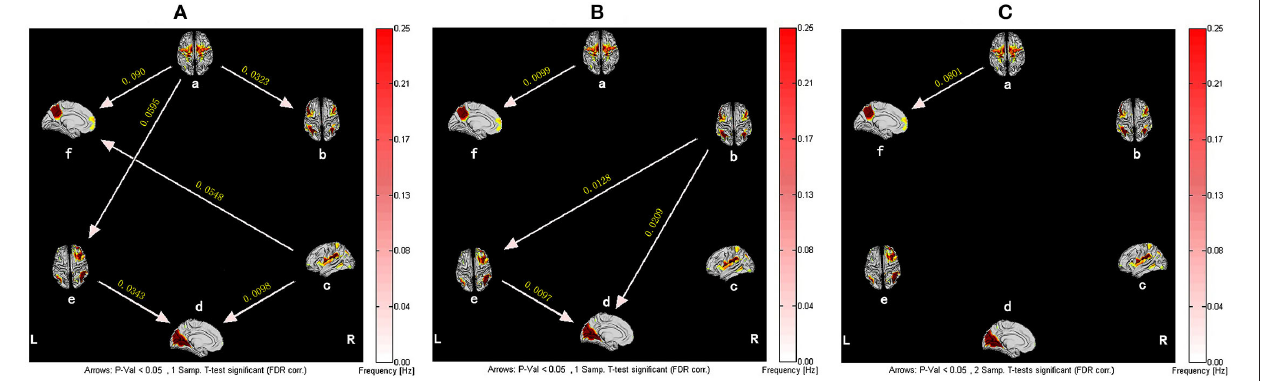
FIGURE 2 | The resting-state effective connectivity comparison between CFS patients and healthy controls. There are six resting-state networks, including: a, SMN; b, ECN; c, SN; d, VN; e, RFPN; f, DMN. Arrow directions represent causal effect between resting-state networks. Yellow numbers indicate strength of causality. Values on the color bar (corresponding with arrow colors) demonstrate frequency at which causality was found. (A) One-sample t -test result of intergroup intranetwork causal relationship of the healthy controls. (B) One-sample t -test result of intergroup intranetwork causal relationship of the CFS patients. (C) Two-sample t -test result of intergroup intranetwork causal relationship of the healthy controls minus the CFS